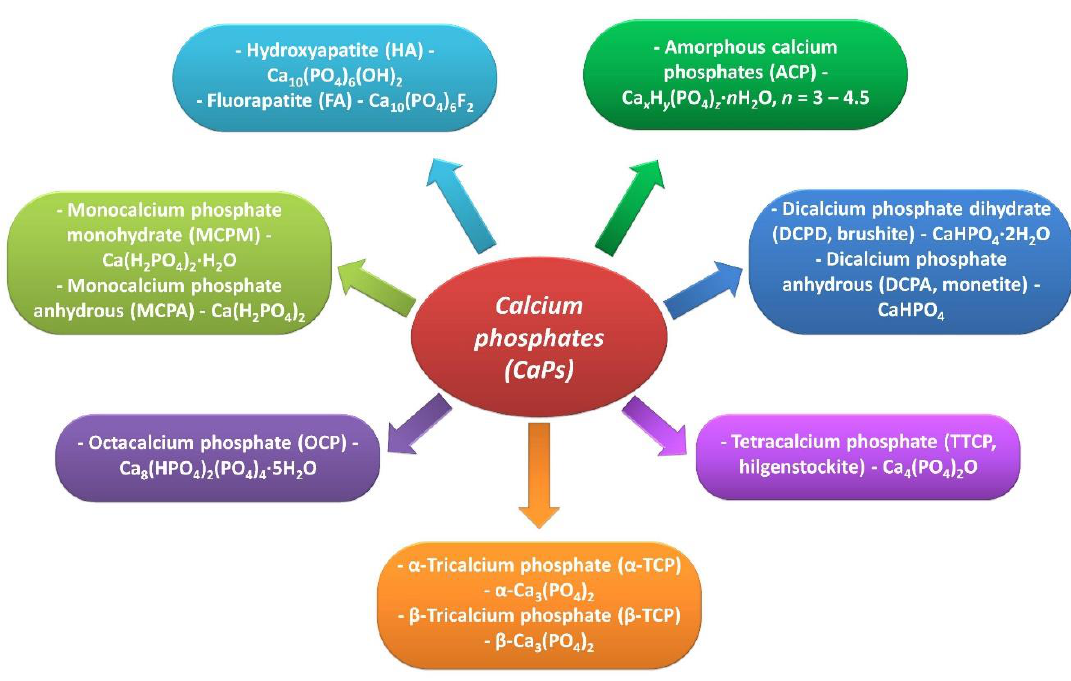
Figure 2. Calcium phosphates in biomedical applications.